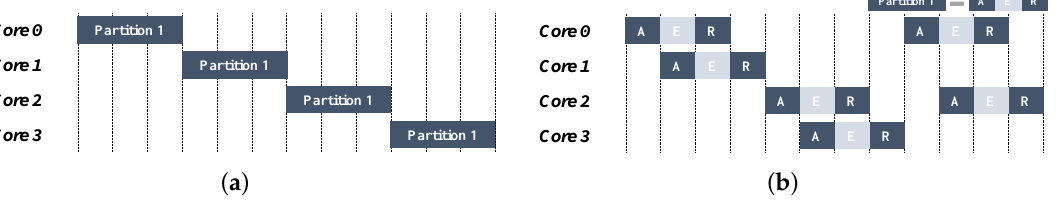
Figure 4. Execution models. ( a ) Time-division multiple access (TDMA). ( b ) Acquisition execution restitution